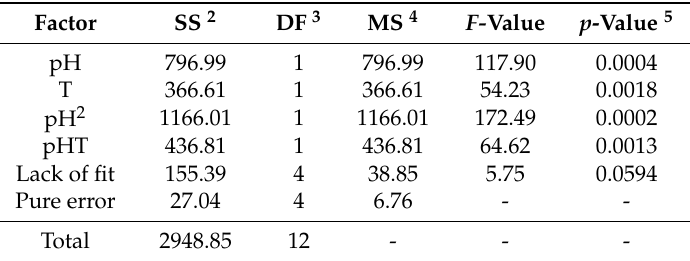
Table 4. ANOVA for the response surface quadratic model for the stability of dLip3 after pH and T treatment for 1 h 1